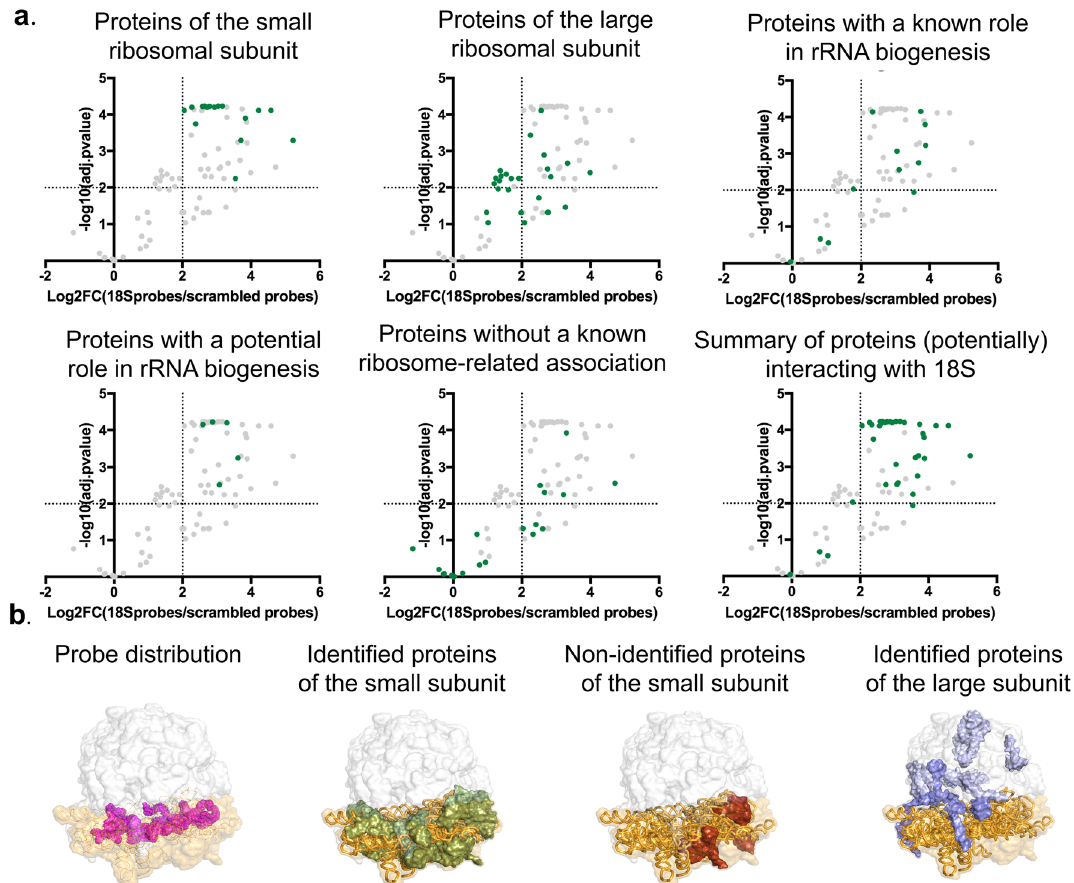
Figure 5. Visualization of different protein groups identified in 18S rRNA interactome ( a ) on volcano plot (in green). Significant proteins are situated in the upper right quadrants (adjusted p-value < 0.01; |log2FC|> 2). From left to right, upper panels: proteins of the small ribosomal subunit, proteins of the large ribosomal subunit, proteins with a role in rRNA biogenesis. From left to right, lower panel: proteins with a potential role in rRNA biogenesis, proteins without known ribosome-related association, summary of proteins (potentially) interacting with 18S. ( b ) CryoEM structure of the yeast ribosome, In orange: 18S rRNA, white shades: large ribosomal subunit, orange shades: small ribosomal subunit. From left to right: Distribution of the probes along 18S rRNA, Significantly enriched proteins of the small ribosomal subunit, Proteins of the small ribosomal subunit not significantly enriched in our dataset, Significantly enriched proteins of the large subunit. In dark blue, the proteins interacting with the 18S